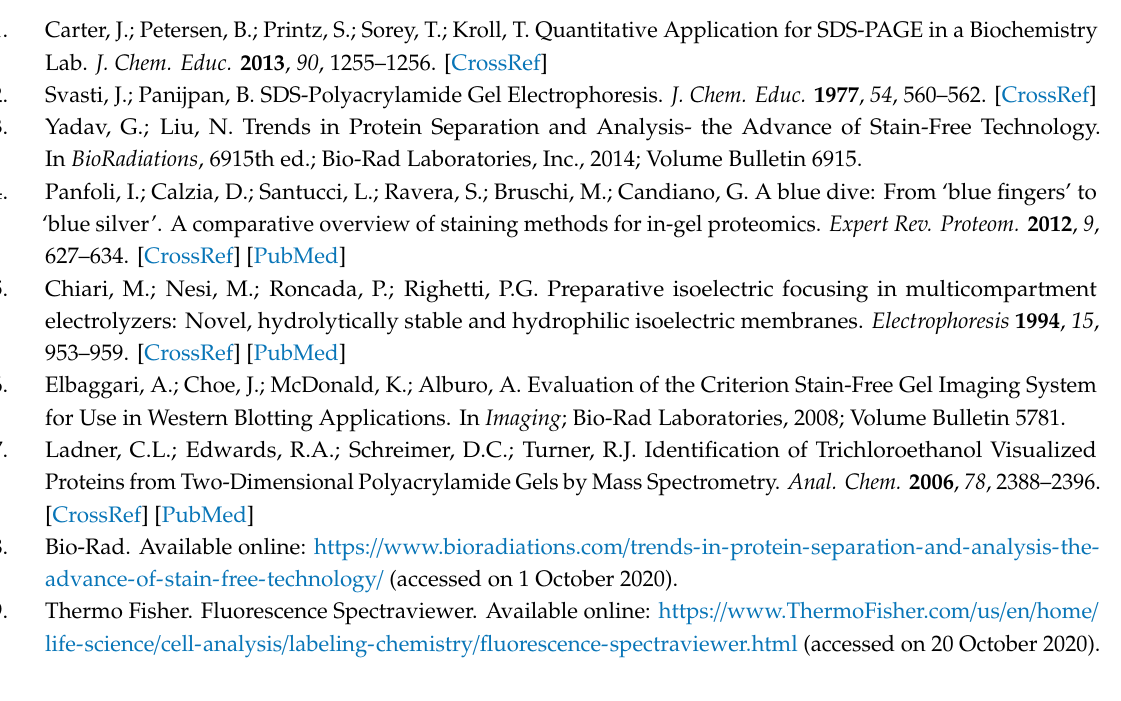
Figure S1: A standard curve (left plot) was created using protein standards included with the µ BCA assay (Thermo Fisher Scientific). The standard curve was used to derive the protein concentration of 4 di ff erent isolations of extracellular vesicle-rich tissue culture medium. These samples were also measured using NanoDrop with datapoints for each technique plotted against one another (right plot). NanoDrop consistently overestimated protein concentration by 13 to